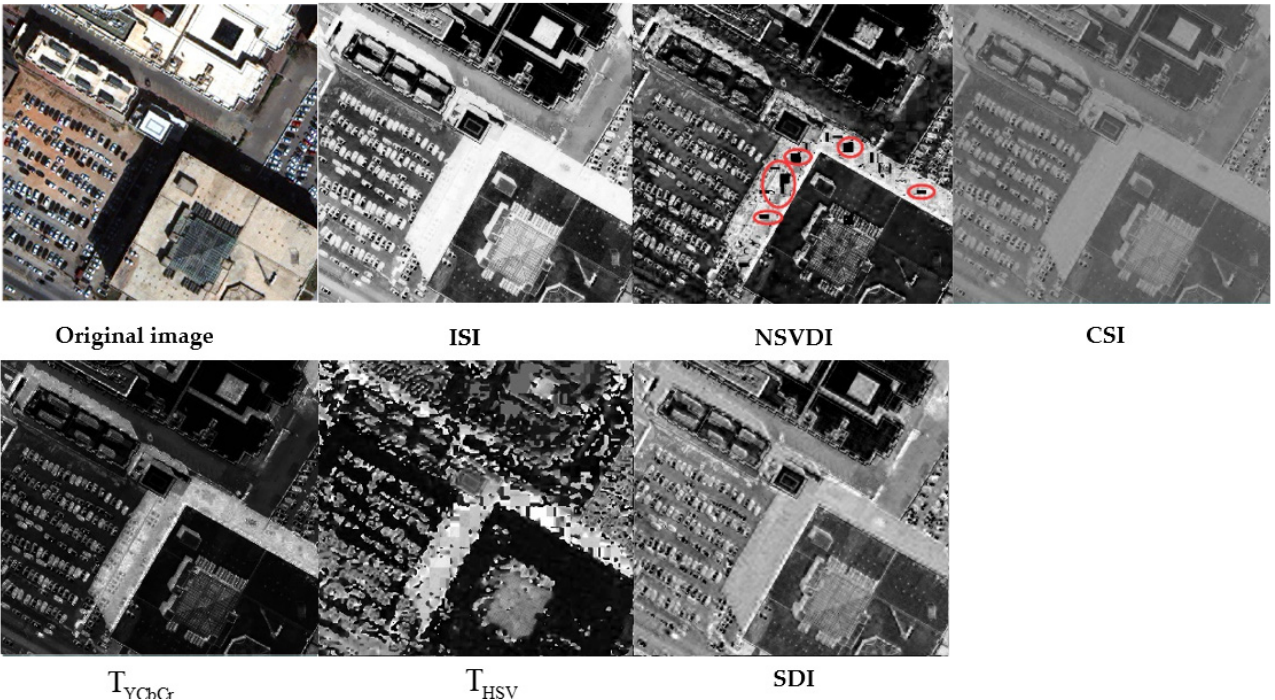
Figure 12. Comparisons of the indexes in Site 2. Comparisons of the indexes in Site 2: ( a ) ISI; ( b ) NSVDI; ( c ) CSI; ( d ) T YCbCr ; ( e ) T HSV ; and ( f ) SDI.